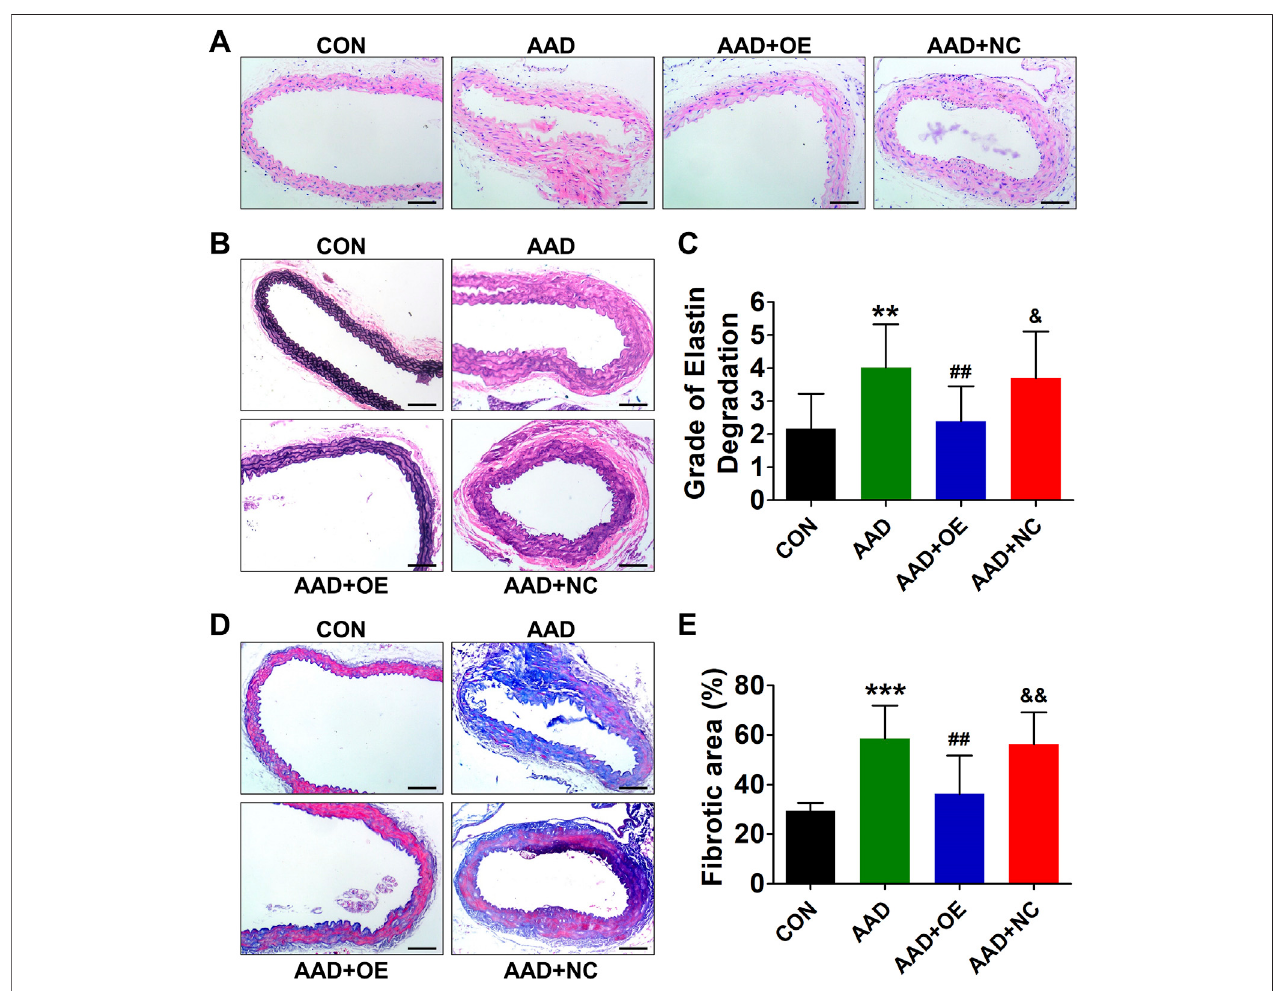
FIGURE 5 | Overexpression of lnc-C2orf63-4-1 prevents AngII-induced aortic elastin fi ber degradation and collagen deposition in aortas of ApoE − / − mice. (A) Representative hematoxylin and eosin staining of the aortas in all groups ( n (cid:1) 4 – 6/per group). (B) Representative EVG staining of aortic elastin in all groups ( n (cid:1) 4 – 6/per group). (C) Quanti fi cationofaorticelastindegradation in (B) . (D,E) RepresentativeMasson ’ strichromestainingimagesandthe fi broticareapercentofaortatissuesinall groups are shown ( n (cid:1) 4/per group). Scale bars (cid:1) 50 μ m. Data of (C) and (E) were compared by analysis-of-variance (ANOVA) with Bonferroni ’ s post-test. ** p < 0.01, *** p < 0.001 vs. control group, ## p < 0.01 vs. AAD group, & p < 0.05, && p < 0.01 vs. AAD + OE group. Data were all expressed as mean ±